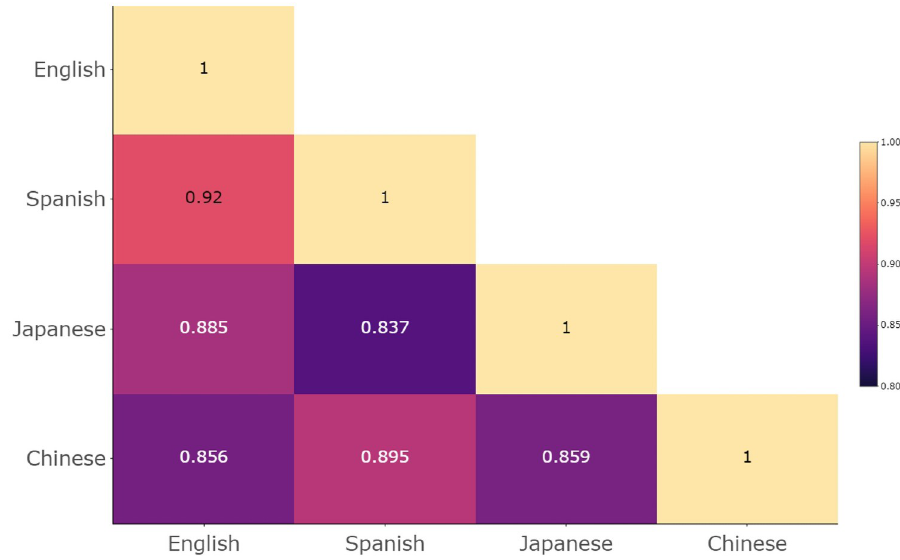
Fig 6. Language-to-language associations similarity in Experiment 1. The matrix shows the Pearson correlation values ( r ) between each pair of language’s 12 × 5 temperature-emotion associations matrix. Higher values indicate higher similarity between the